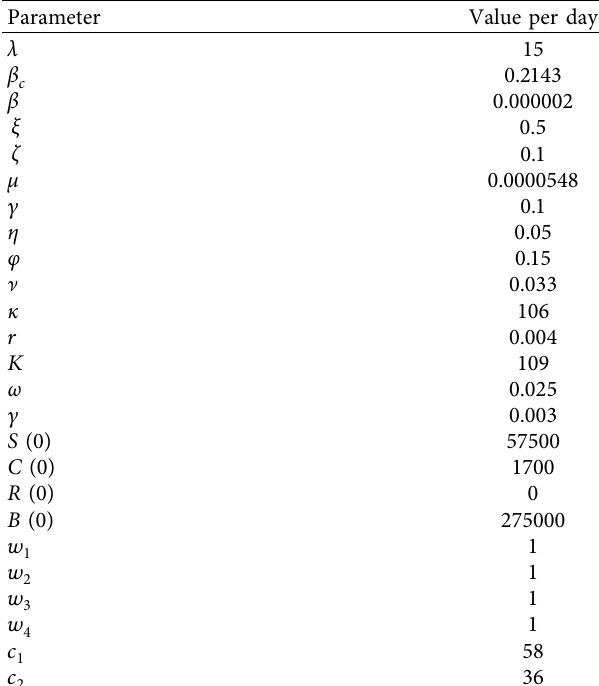
Table 1: Descriptions of parameter